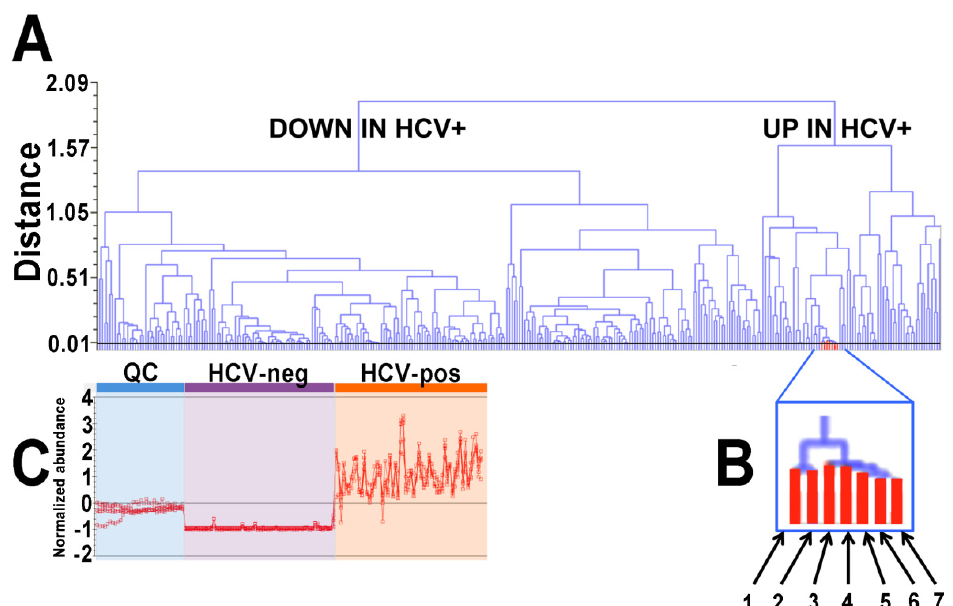
Figure 2. ( A ) Up- and down-regulated plasma metabolites in HCV-positive patients displayed in a dendrogram. ( B ) A single node contained all seven fatty acid amides detected by UPLC-ESI-QTOFMS, as follows: 1, decanamide; 2, dodecanamide; 3, palmitamide; 4, stearamide; 5, palmitoleamide; 6, linoleamide; 7, eicosatetraenamide. ( C ) Abundance profiles for the seven FAAs across 21 QC samples, 30 HCV-negative samples, and 30 HCV-positive samples.